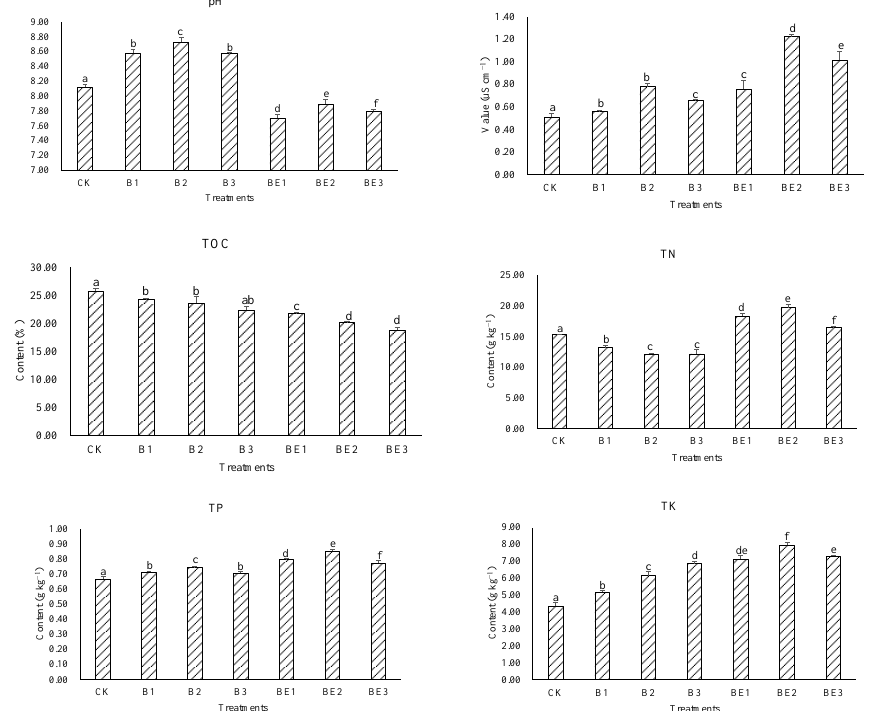
Figure 2. Physical and chemical properties of the sludge for different treatments. Data are presented as the mean ± SD for three duplicates. Columns with different letters show a significant difference at p < 0.05 level.